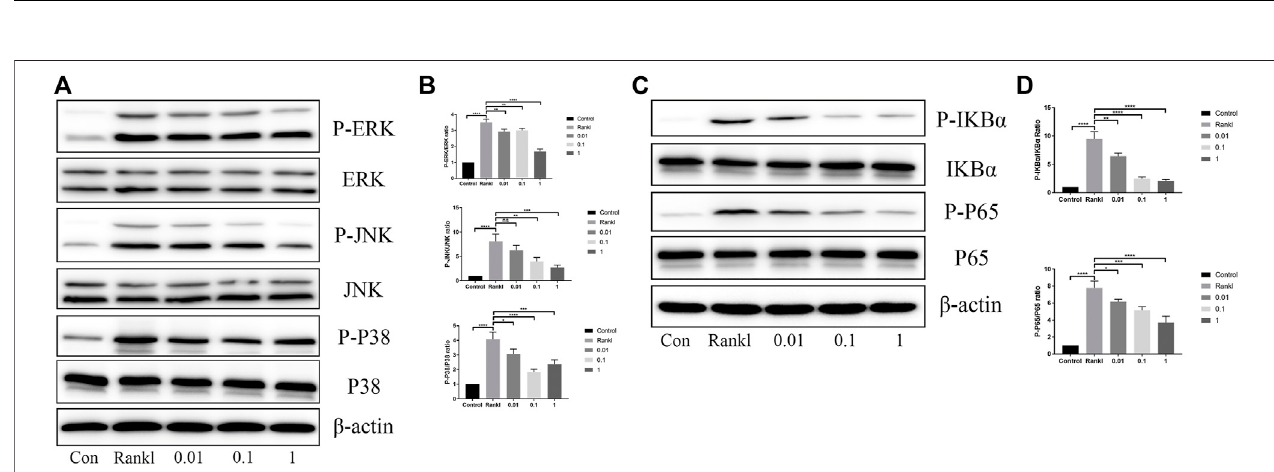
FIGURE5| BSsuppressed RANKL-inducedactivationofMAPKsandNF-kB. (A) Representative westernblotofERK,JNK,andp38phosphorylation treatedwith BS after RANKL induction. (B) Quantitative analysis of phosphorylated ERK, JNK, and p38 to total ERK, JNK, and p38. (C) Representative western blot of p65 degradation and IkB- α phosphorylationtreated with BS after RANKL induction. (D) Quantitative analysis ofphosphorylated IkB- α and p65 tototal IkB- α and p65. All bar graphs are presented as mean ± SD; n = 3. p p < 0.05; pp p < 0.01; ppp p < 0.001; **** p < 0.0001.